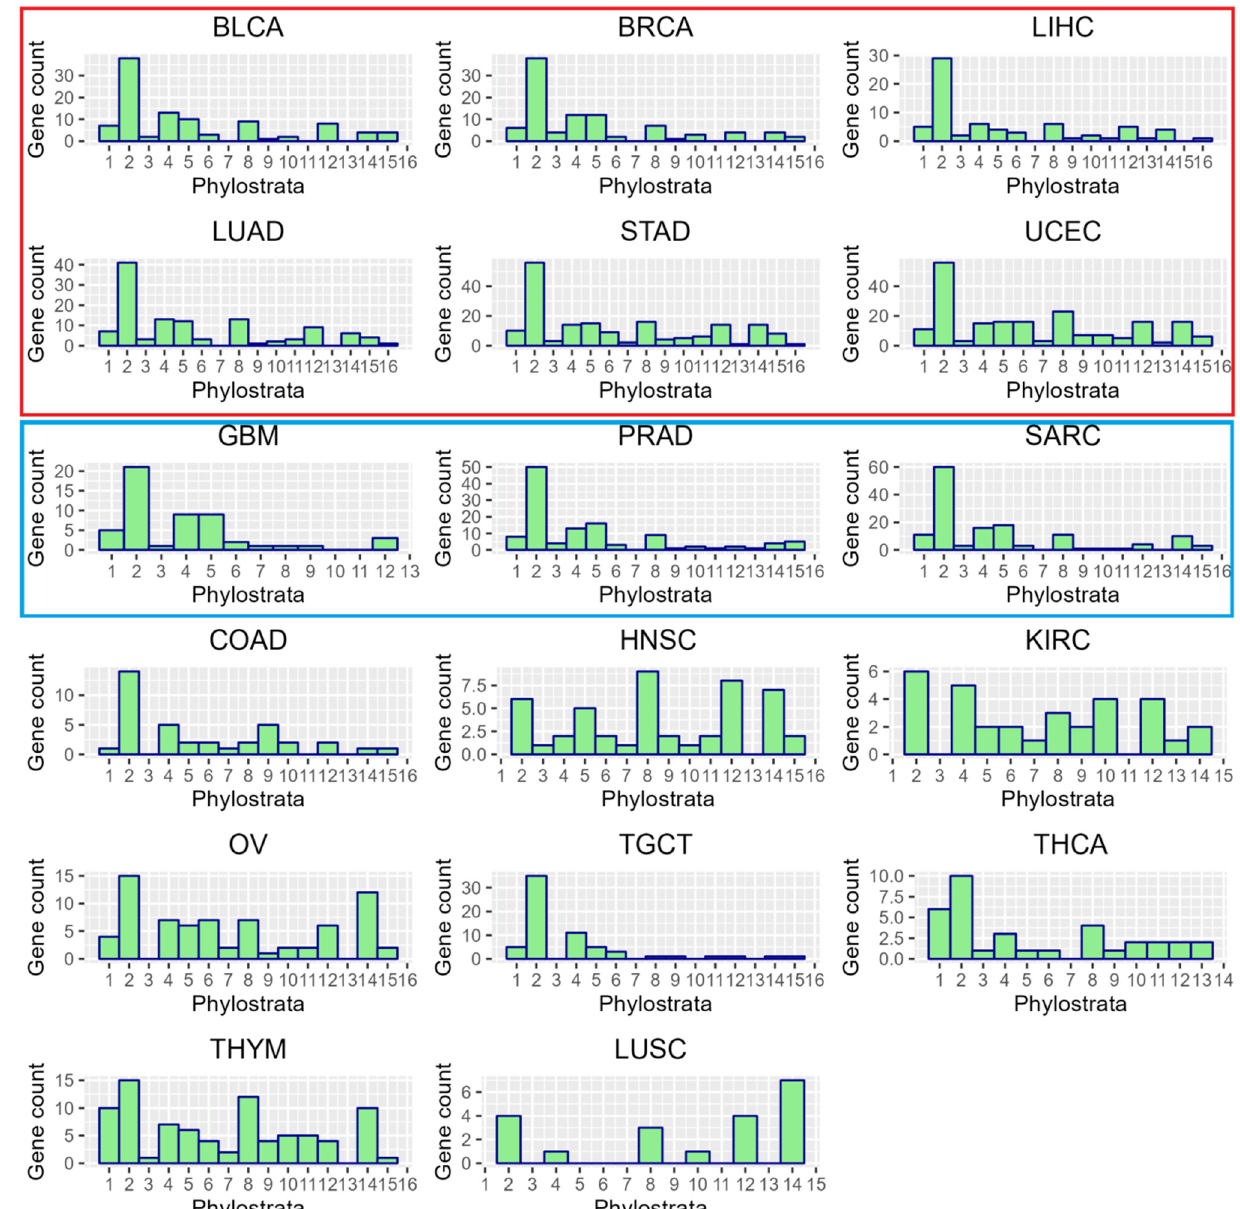
Figure 4. The phylostratigraphic distribution of ploidy-upregulated GG genes in 17 primary TCGA tumour types (that meet the criteria of having >10 ploidy-upregulated GG genes). The histograms of the 6 tumour types whose STRING and coexpression networks of upregulated genes are enriched for meiosis and gametogenesis-related GO and KEGG modules are highlighted in red, the 3 tumour types for which the former is true only in the case of STRING networks—in blue. Notably, they have a similar pattern of phylostratigraphic distribution of GG genes along the evolutionary tree, which is also similar in COAD and represents the most frequent types of somatic human cancers. Abbreviations are the same as in Table